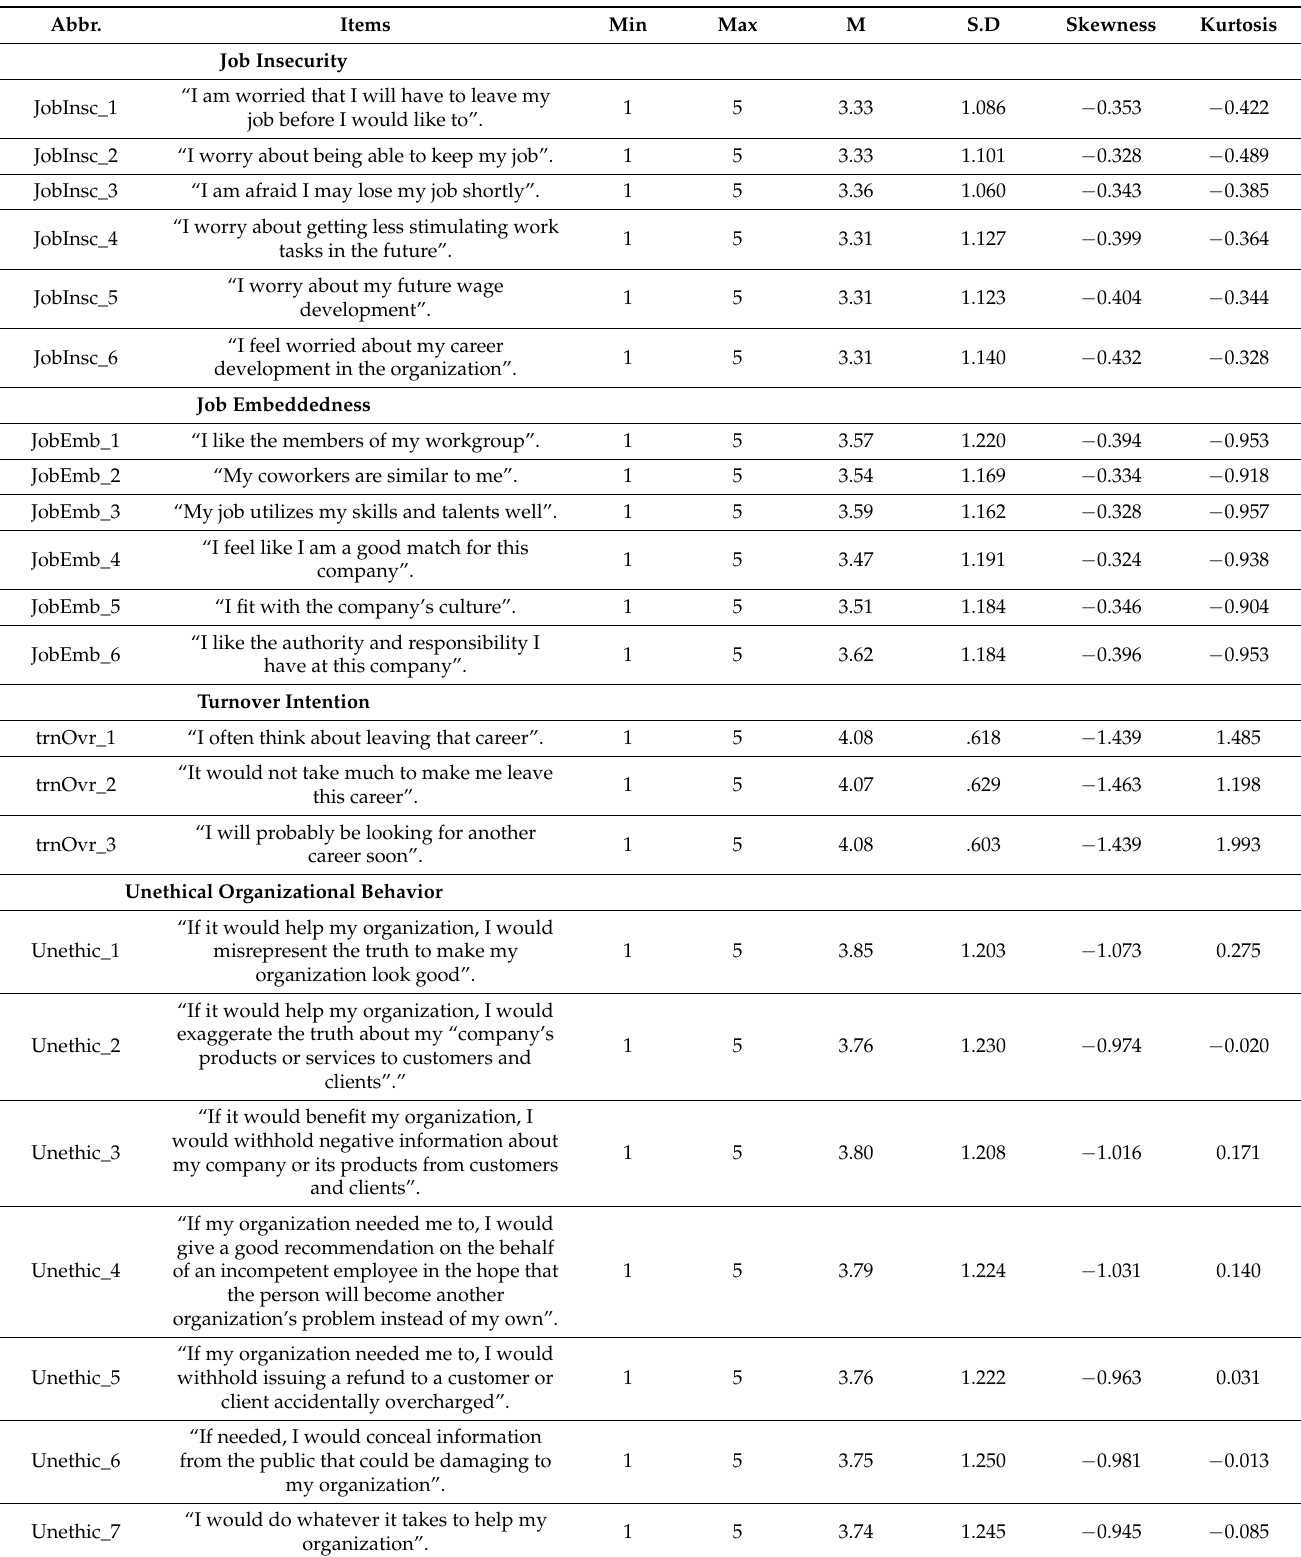
Table 2. Descriptive statistics (developed by authors based on previous